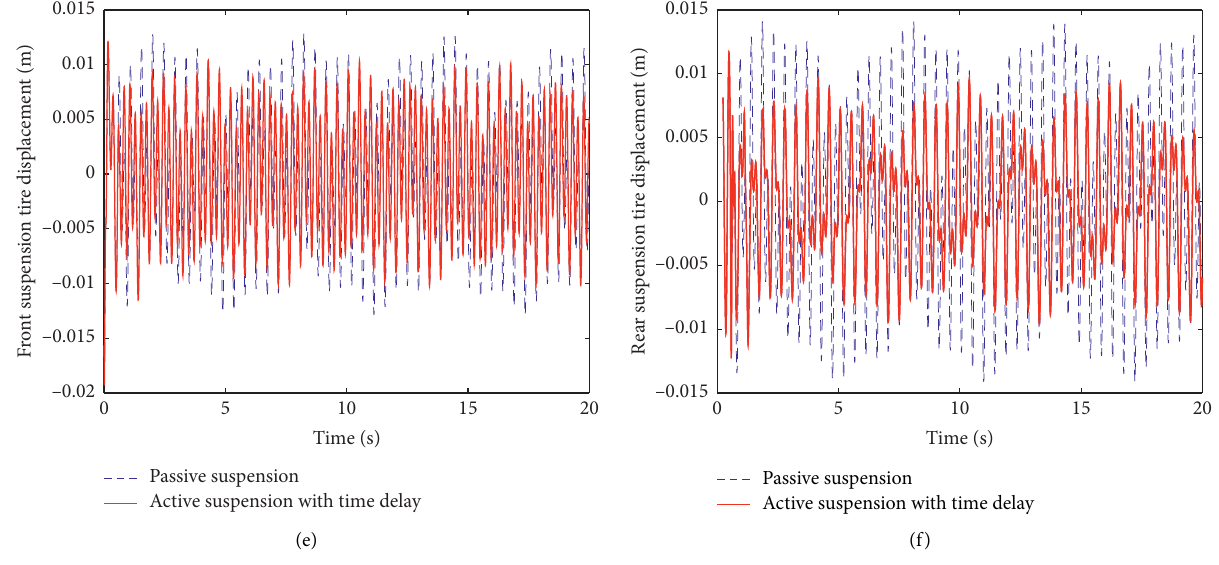
Figure 7: Simulation comparison of smoothness index under complex excitation. (a) Body acceleration. (b) Body pitch acceleration. (c) Dynamic deflection of the front suspension. (d) Dynamic deflection of the rear suspension. (e) Front suspension tire displacement. (f) Rear suspension tire Table 3: RMS value of ride comfort index under random excitation.